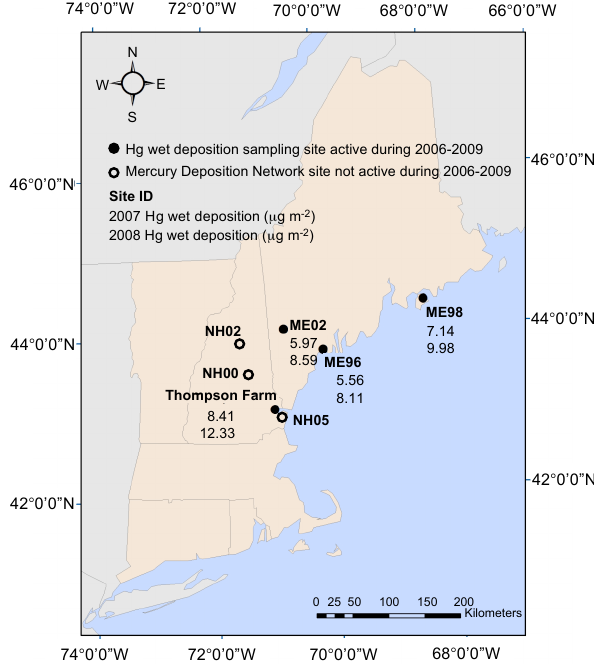
Fig. 1. Thompson Farm location and Mercury Deposition Network locations in Maine and New